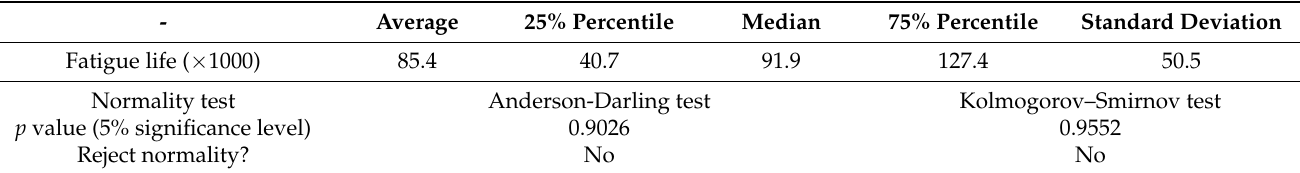
Table 5. Four-point beam fatigue test results and statistical normality tests.